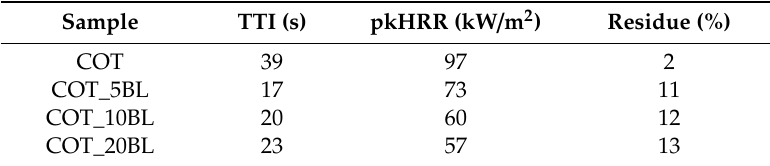
Table 12. Cone calorimetry data of untreated and LbL-treated cotton fabrics.